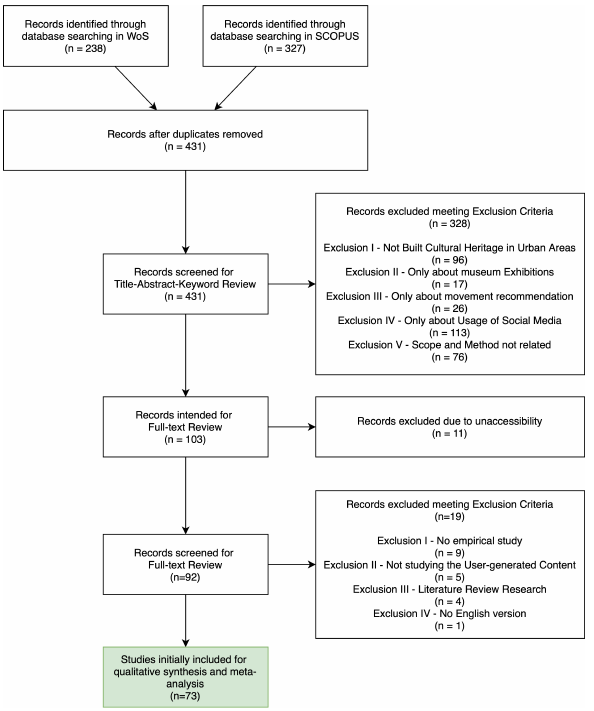
Figure 5. The systematic literature review